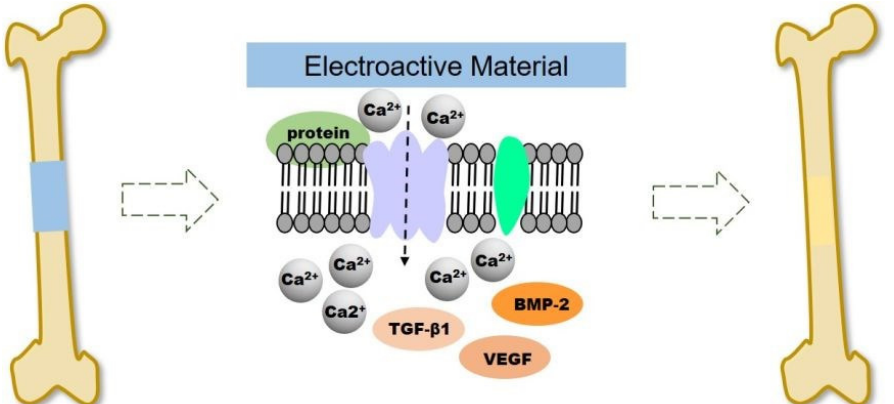
Figure 7. Schematic illustration of electroactive scaffold to induce bone regeneration. Reproduced with permission from [113] . Copyright (2020) Royal Society of Chemistry.